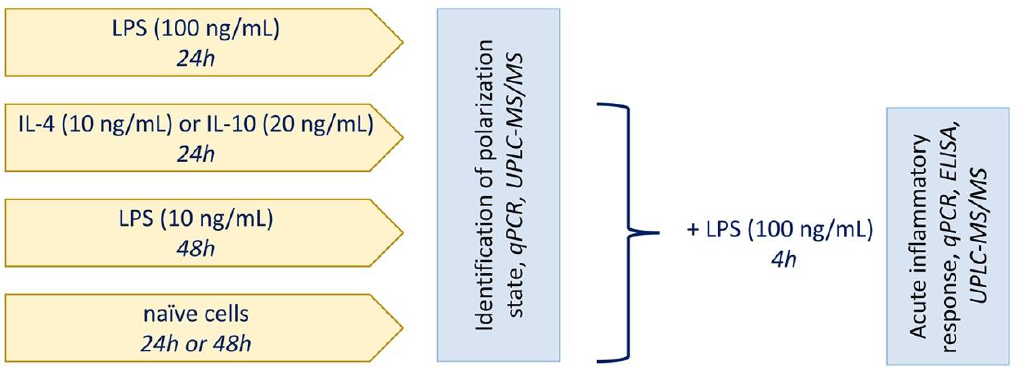
Figure 5. General scheme of treatment.